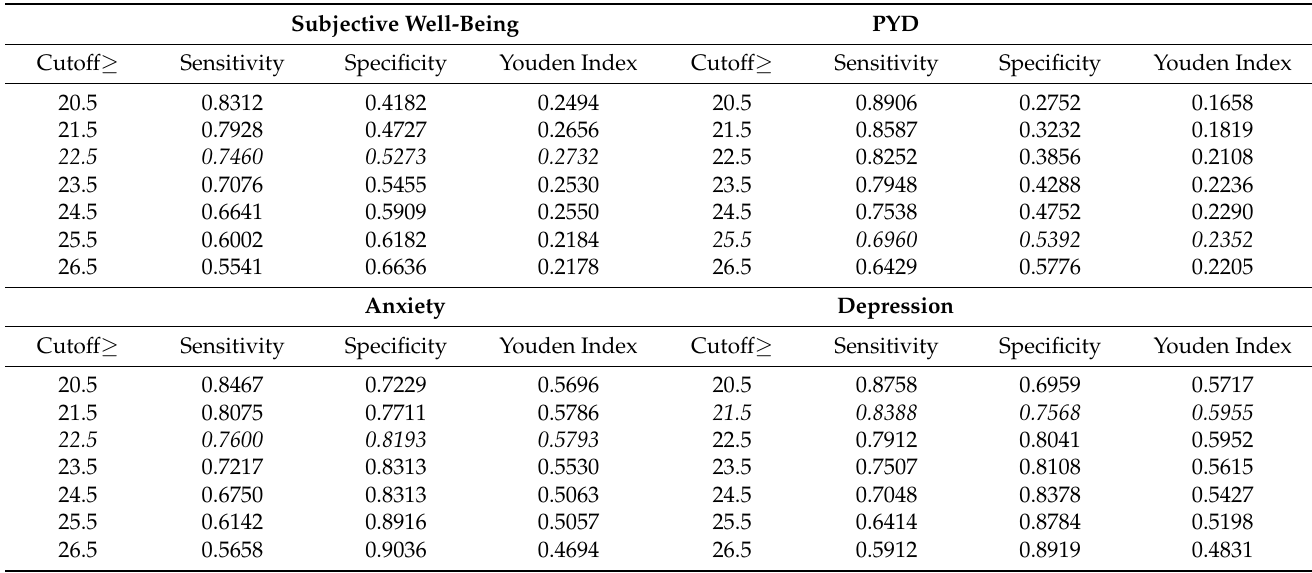
Table 4. Sensitivity, specificity, and Youden index for a selection of best cutoff points of the Chinese version of the CAMM for